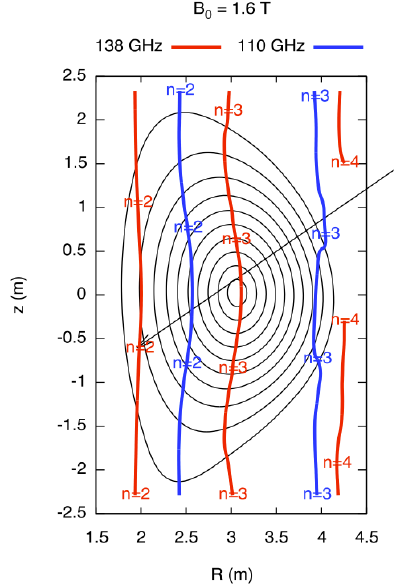
Fig. 7. EC resonances for B 0 =1.6 T (case 8).